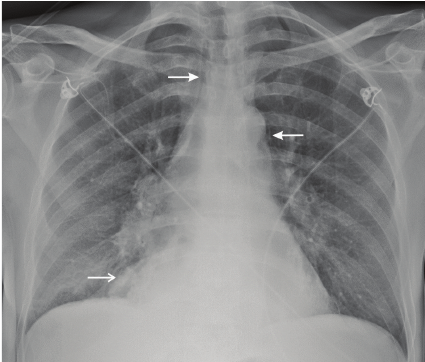
Figure 1: Chest X-ray at admission at the emergency ward showing a pneumomediastinum (closed arrows) and silhouette sign over the right heart border (open arrow). No pleural effusions were observed in the costolateral sinuses.